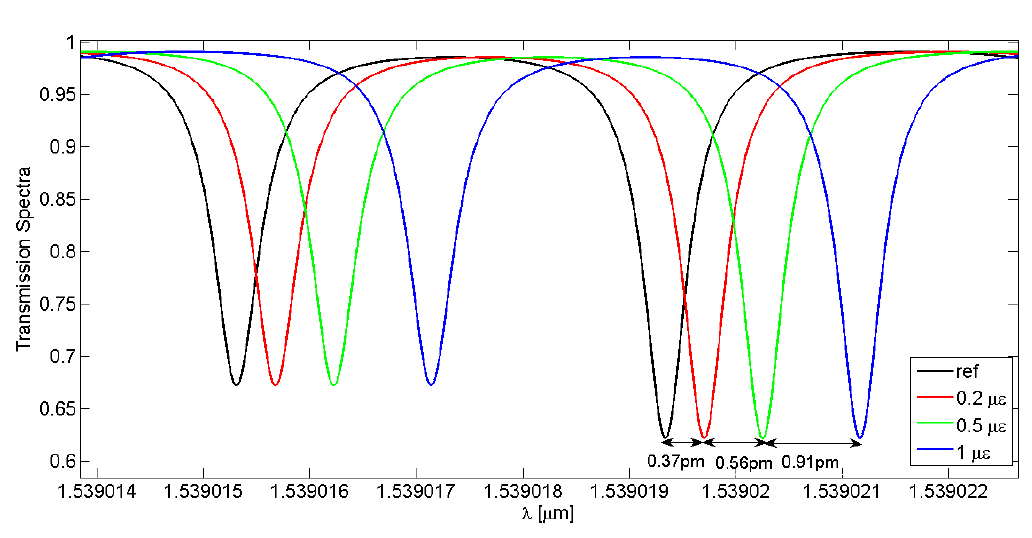
Figure 9. LPGRR spectral responses as a function of the applied strain in the range of 0–1 µε .